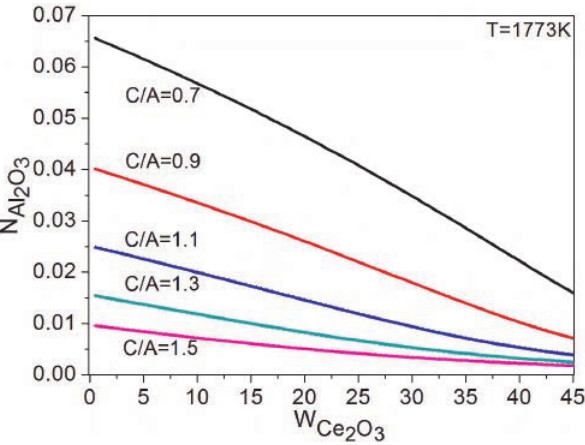
Fig. 3: The influence of CaO/Al 2 O 3 and Ce 2 O 3 content on mass action concentration of Al